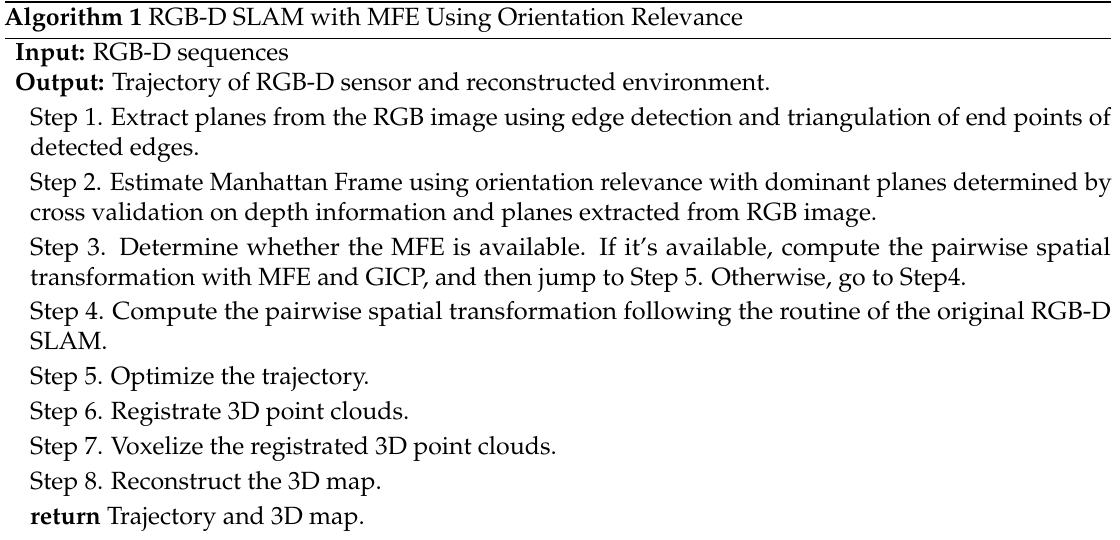
Algorithm 1 RGB-D SLAM with MFE Using Orientation Relevance